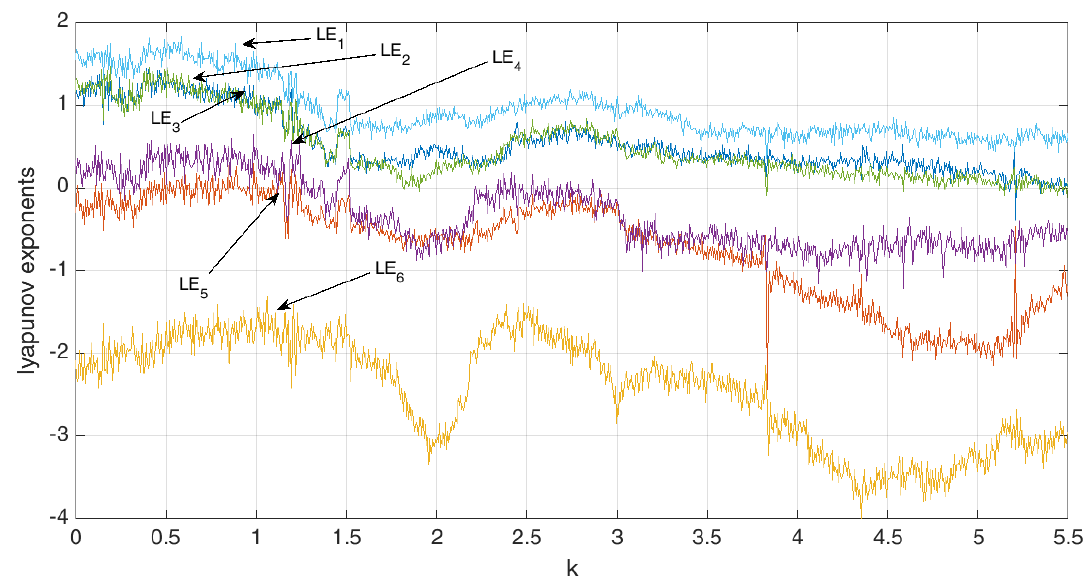
Figure 3. Lyapunov exponent spectrum of the new system (43) in k ∈ ( 0,5.5 )